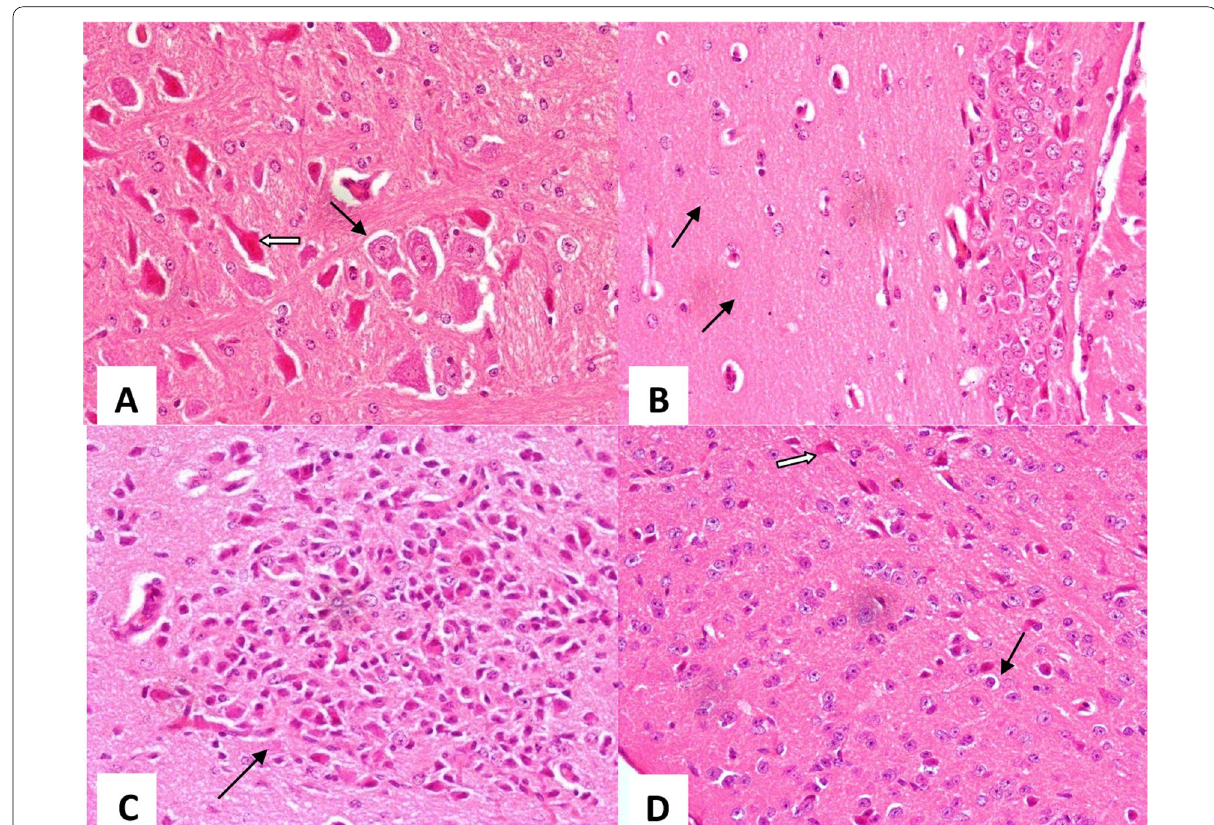
Fig. 7 A Brain tissue of mice treated with ( l -dopa CAF PQ) showing restored cellularity with several neuronal cells, non-pigmented with large + + rounded nuclei and prominent nucleoli (black arrow). Adjacent pyramidal pigmented neuronal cells were seen as well (white arrow). B Brain tissue of mice treated with ( l -dopa CAF PQ) showing organized, cellular Purkinje cell layer with adjacent tissues showing marked improvement with + + no vacuolar degeneration (black arrows). C Brain tissue of mice treated with ( l -dopa CAF PQ) showing prominent restored cellularity (black + + arrow). D Brain tissue of mice treated with ( l -dopa CAF PQ) showing cellular tissue, with several oligodendroglial (black arrow) and pigmented + + neuronal cells (white arrow) together with markedly improved background with minimal residual vacuolar degeneration (H&E